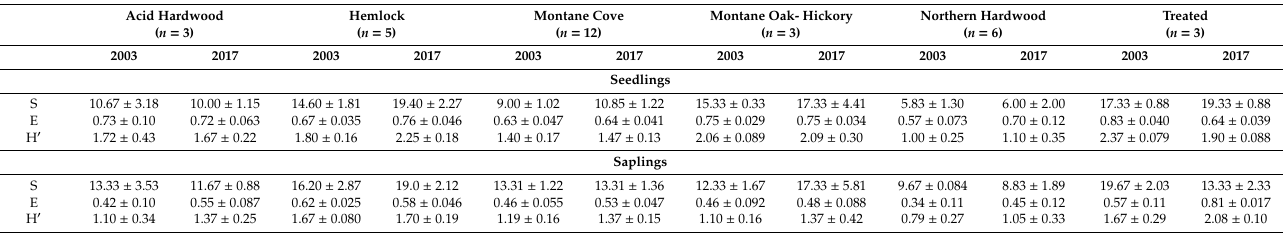
Table 4. Richness (S), Evenness (E), and Shannon-Wiener Diversity (H (cid:48) ; Mean ± SE) by strata across ecogroups and chemically treated